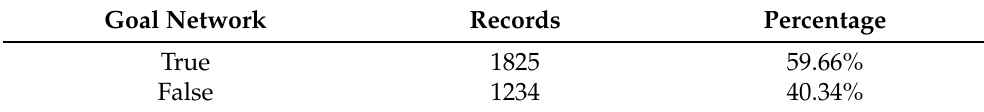
Table 2. Sensor network deployment distribution by having a goal